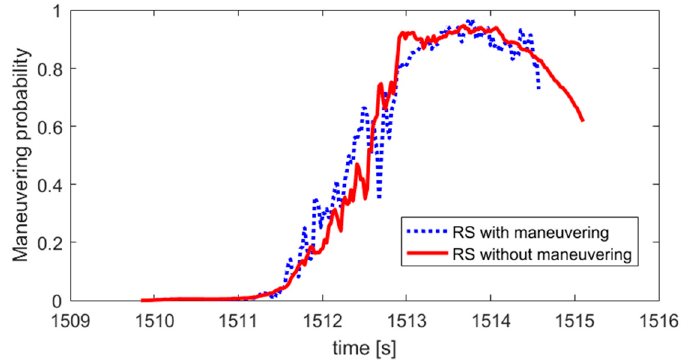
Figure 10. Maneuvering probability of NCSO.